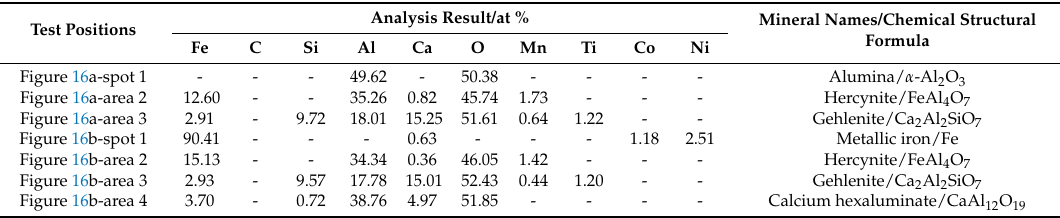
Figure 16. SEM micrographs of the alumina slag with alumina phase ( a ) and the alumina slag ( b ) obtained at the optimal condition. Table 4. EDS results of the alumina slag obtained at the optimal condition.